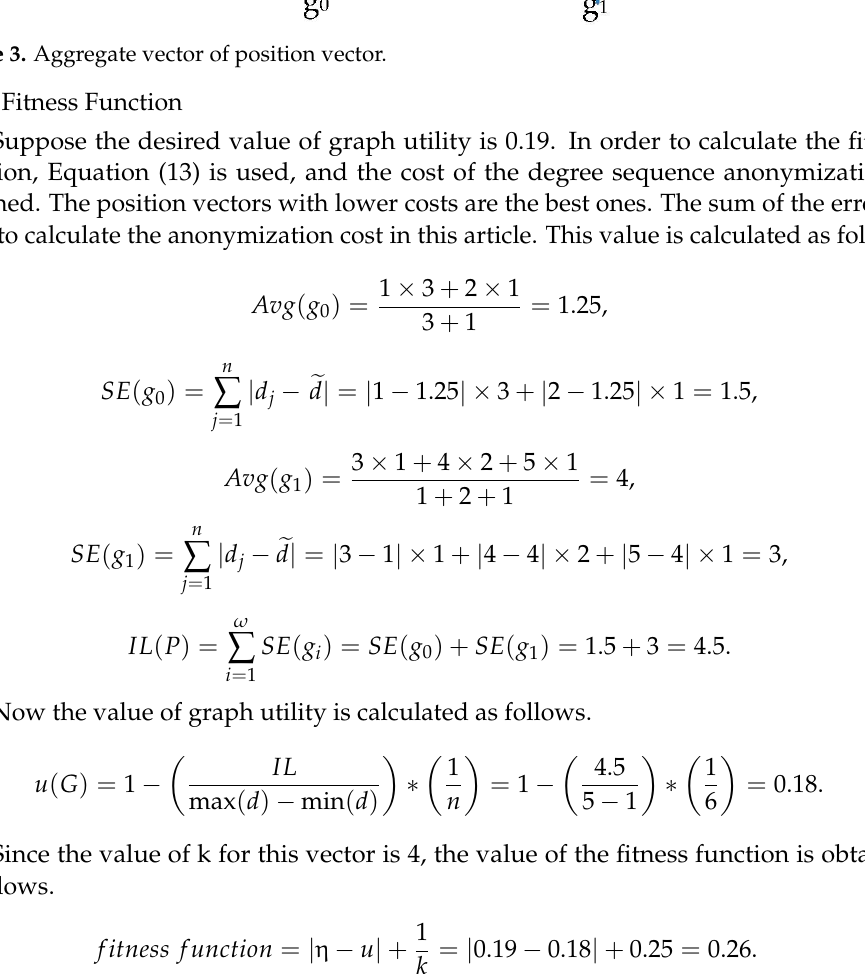
Figure 4. Position vector .